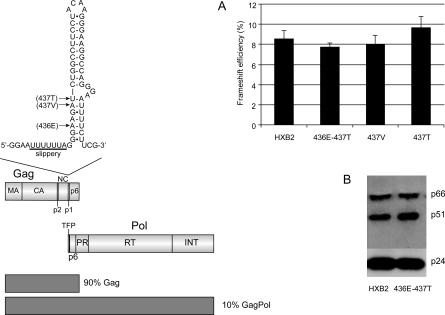
Schematic Representation of the Viral Frameshift Region and Investigation of Frameshift EfficiencyThe RNA structure of the frameshift stimulatory signal is represented here [30,51]. The nucleotide and amino acid changes (between brackets) as observed in our in vitro selection experiments are indicated.(A) The relative frameshift efficiency of wild-type HIV (HXB2) and the p1 constructs of IVS-1 (436E+437T), IVS-32 (437V), and IVS-34 (437T). The values of the frameshift efficiency are the means of four independent experiments, with bars representing the standard errors.(B) Analysis of differences in levels of HIV GagPol products (RT, p66, and p51) as compared to HIV Gag products (CA, p24) by Western blot analysis.